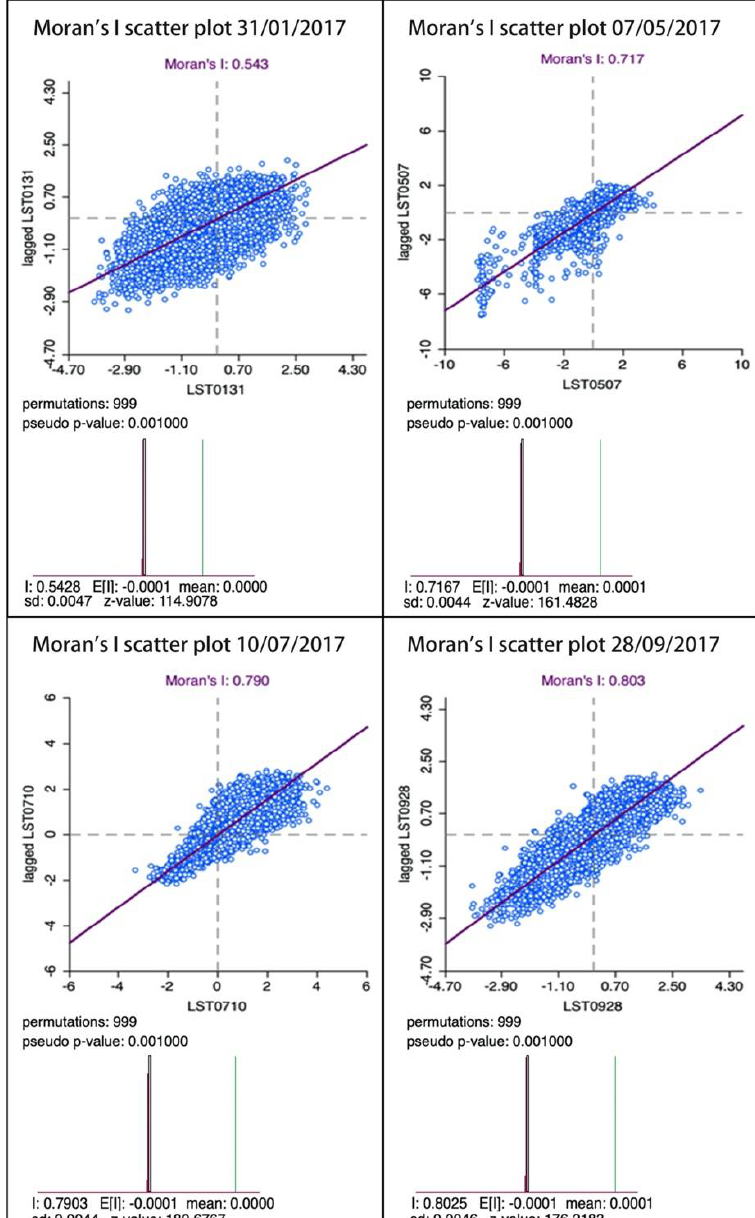
Figure 6. Moran’s I scatter plots of LST: 31 January 2017, 7 May 2017, 10 July 2017, and 28 September 2017.